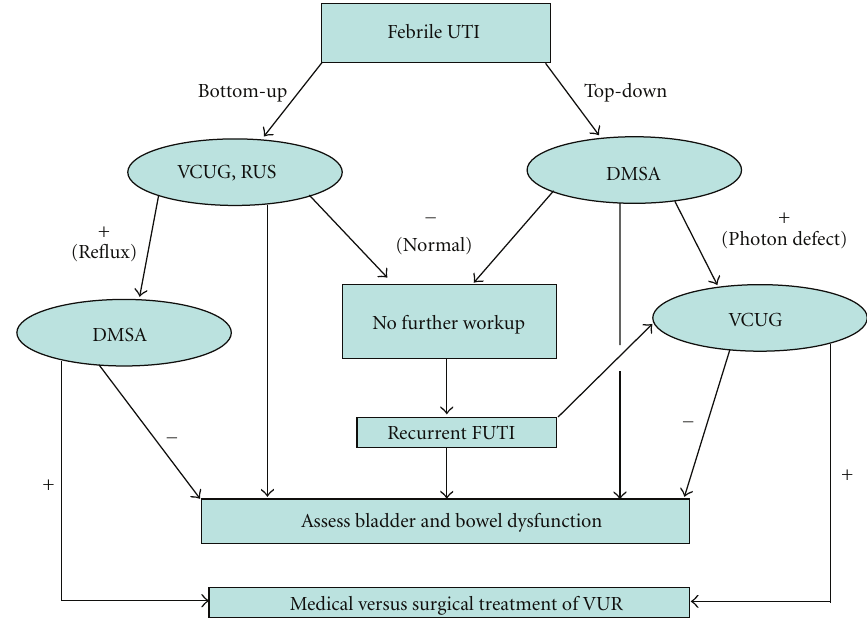
Figure 1: A schematic of the bottom-up versus top-down